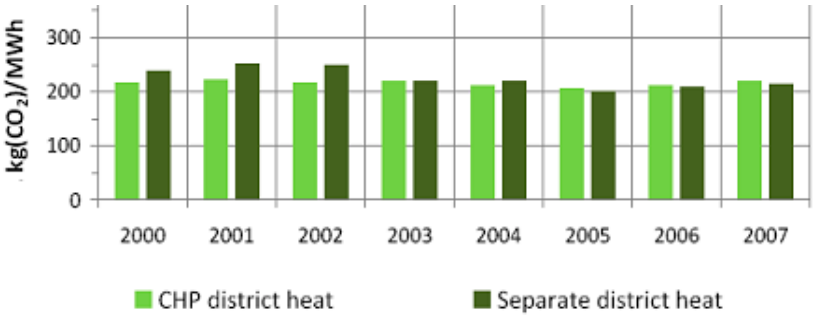
Figure 3. The specific emissions of the district heating energy [56].